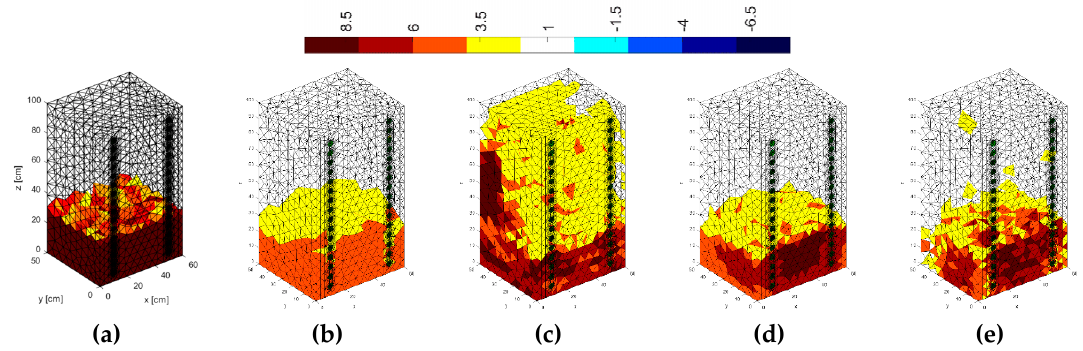
Figure 18. Reconstructions for variant #4: ( a )—Pattern, ( b )—Total Variation, ( c )—LARS, ( d )—Elastic Net, ( e )—ANN.